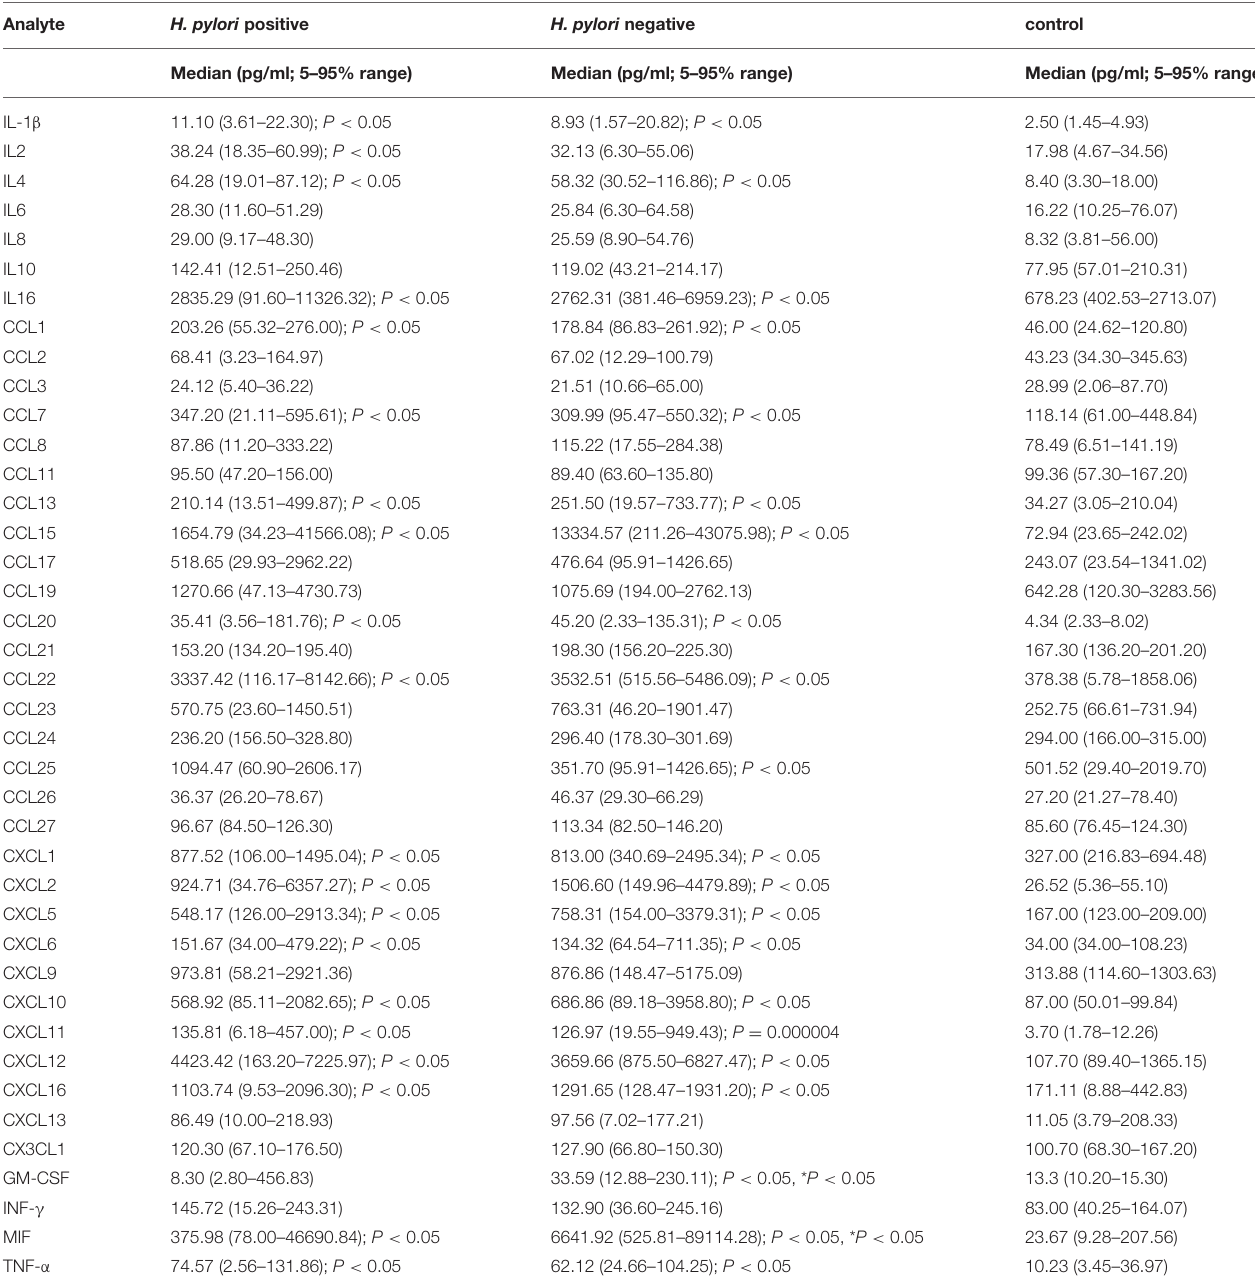
TABLE 2 | Serum cytokine profile of children diagnosed with H. pylori positive and negative